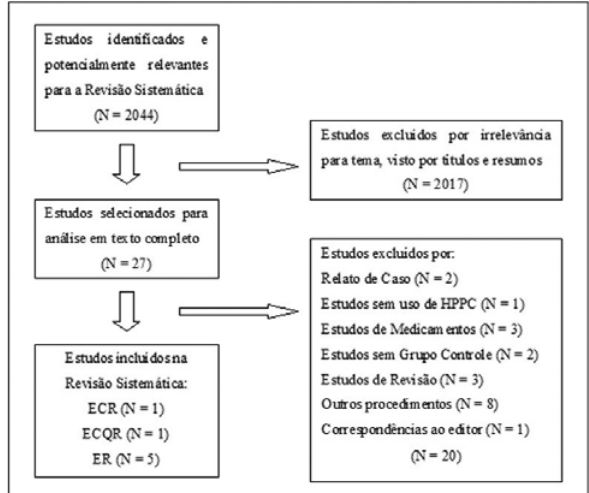
Fig. 3 - Fluxograma da coleta de artigos. ECR = Ensaio Clínico Controlado e Randomizado; ECQR = Ensaio Clínico